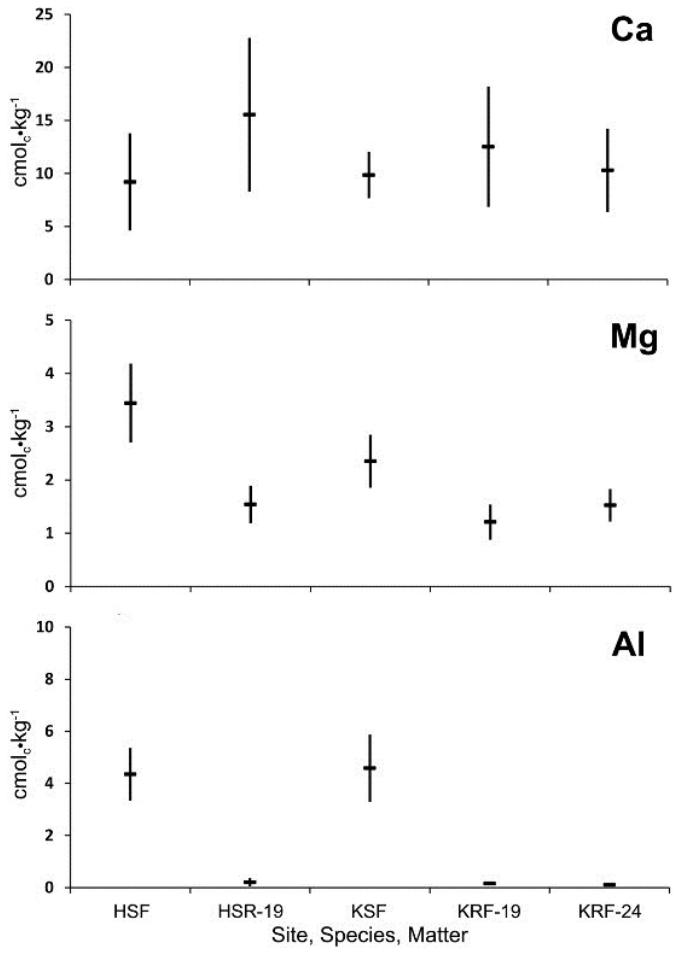
Figure 7. Comparison of mean concentration of exchangeable Ca, Mg, and Al and 95% confidence interval ( n = 10 forest floor; n = 5 decayed wood) for the lower forest floor (F) at Howland, ME (H), and Kossuth, ME (K), and decayed wood (R) of red spruce after 19 and 24 years of decay with ground contact.